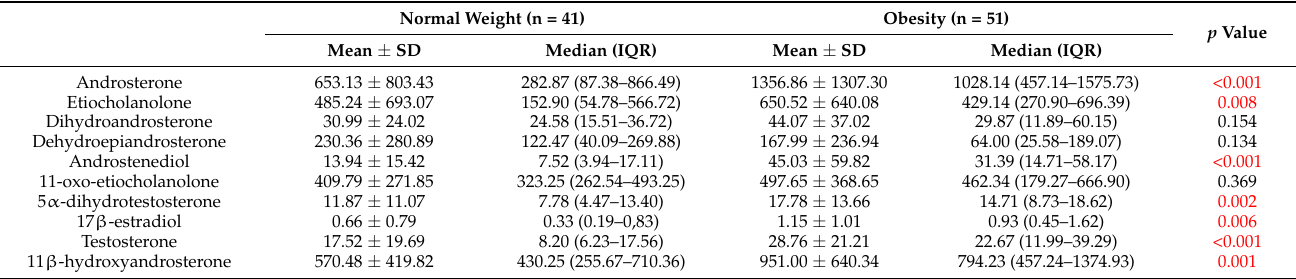
Table 3. List of steroid metabolites ( µ g/24 h): differences between the normal weight and obesity in